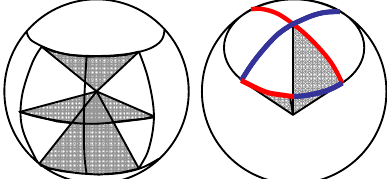
Figure 10. The partition curve surface corresponding to b -curve